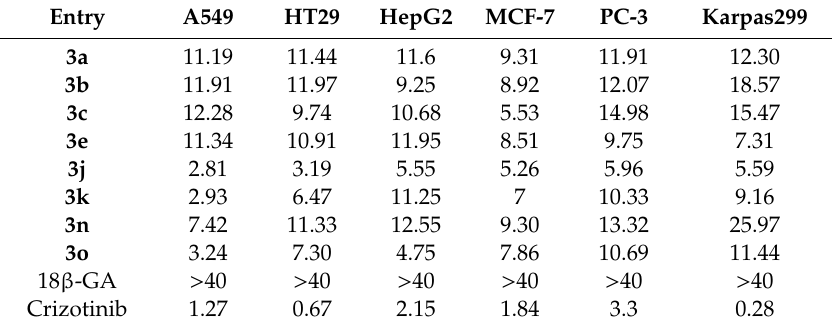
Table 3. Antiproliferative activity (IC 50 , μ g/mL) of selected compound.